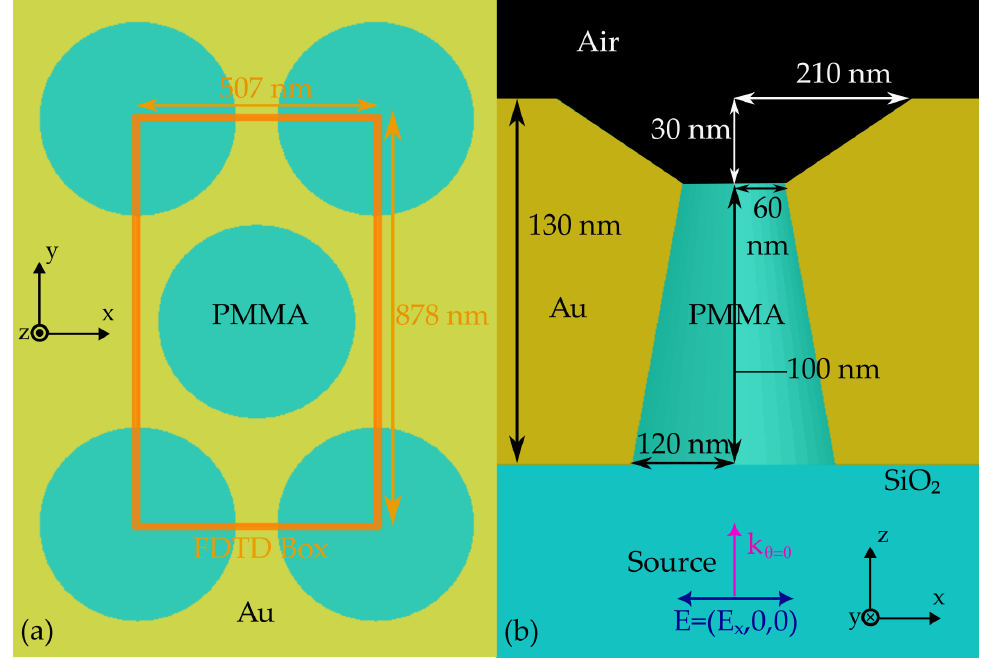
Figure A1. Top ( a ) and side ( b ) views of the FDTD optimized structure. The geometrical parameters of the structural model obtained from the tuning process are displayed together with their dimensions.